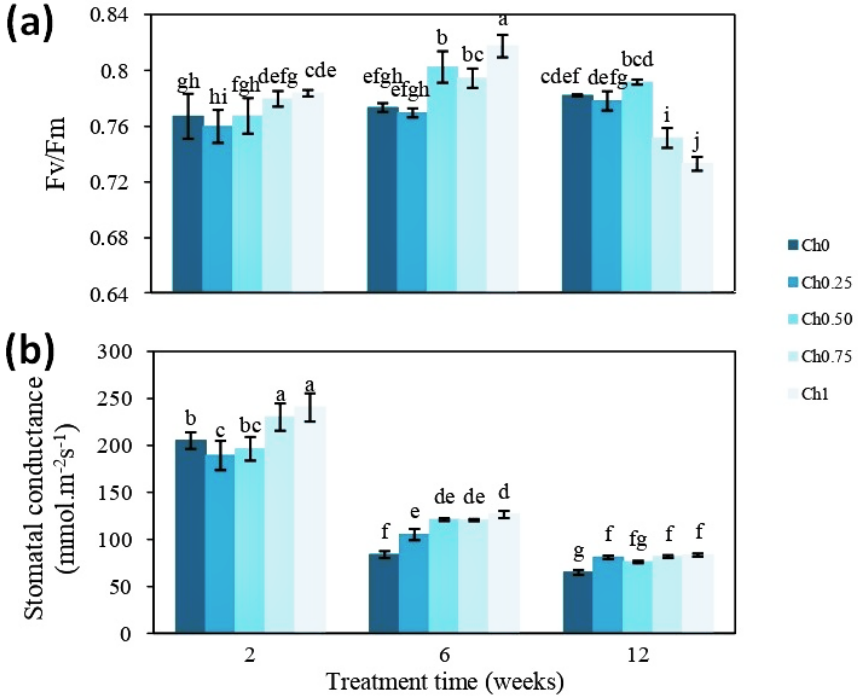
Figure 3. Evolution of chlorophyll fluorescence ( a ) and stomatal conductance ( b ) in plants treated and non-treated with chitosan. Five treatments were applied until fruit ripening with 0 mg mL −1 (Ch0), 0.25 mg mL −1 (Ch0.25), 0.50 mg mL −1 (Ch0.50), 0.75 mg mL −1 (Ch0.75), and 1 mg mL −1 (Ch1) chitosan. Data were obtained after the 2nd, 6th, and 12th week of treatment. Results were expressed as the mean of 4 independent replicates ± SD. Values followed by different lowercase letters are significantly different according to Duncan’s multiple range test ( p ≤ 0.05).